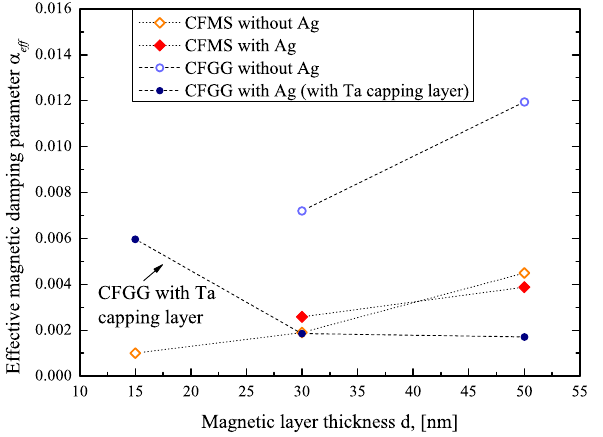
Figure 7. Effective magnetic damping parameter α eff for CFMS and CFGG samples as a function of magnetic layer thickness at room temperature.